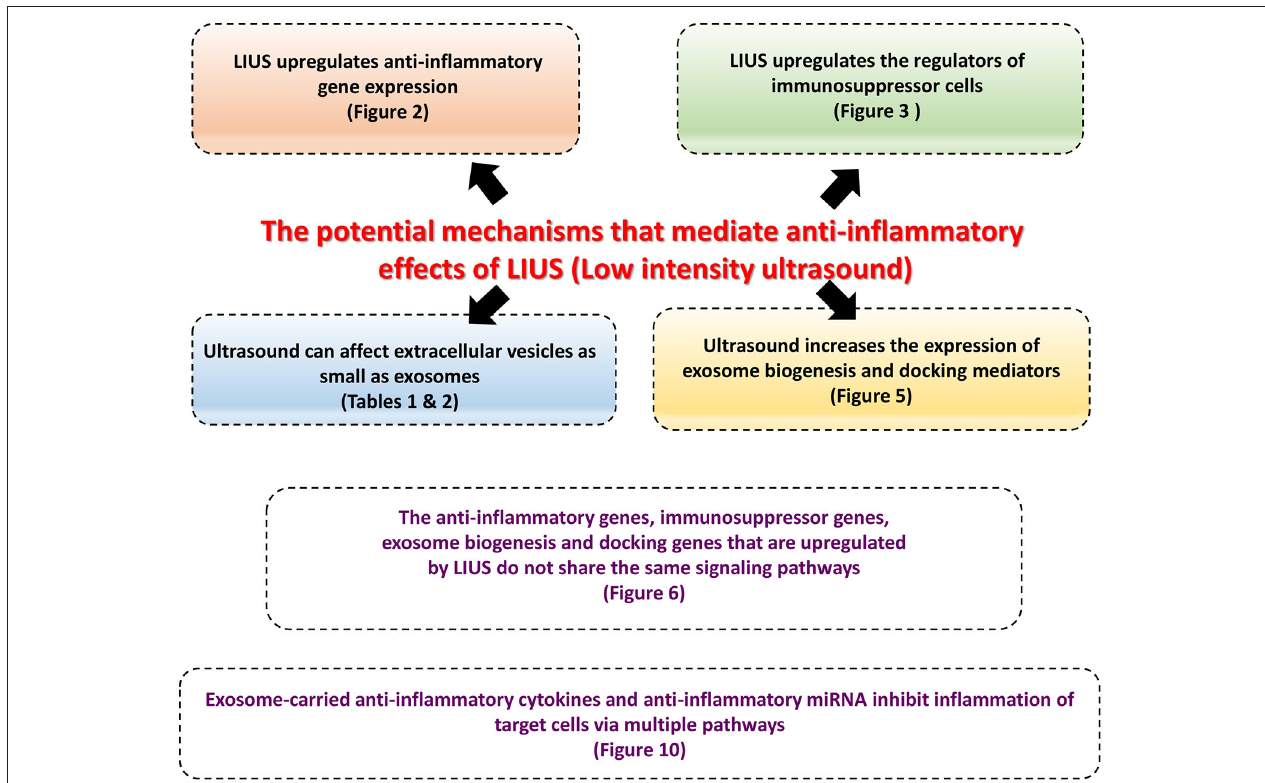
FIGURE 1 | The logic flow and the overview of the manuscript.